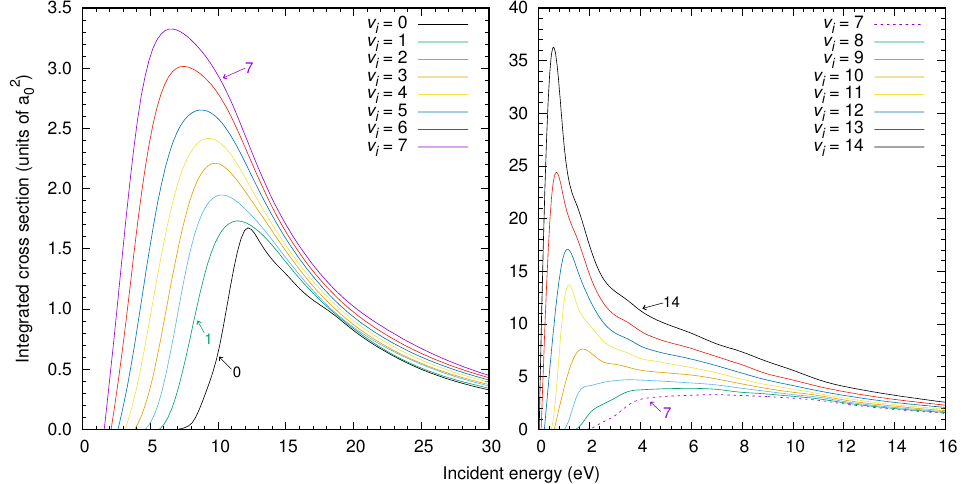
Figure 1. Electron-impact cross sections for excitation from the v i = 0–14 vibrational levels of the X 1 Σ + g state to the dissociative b 3 Σ + u state of H 2 . The cross sections increase monotonically with increasing v i .